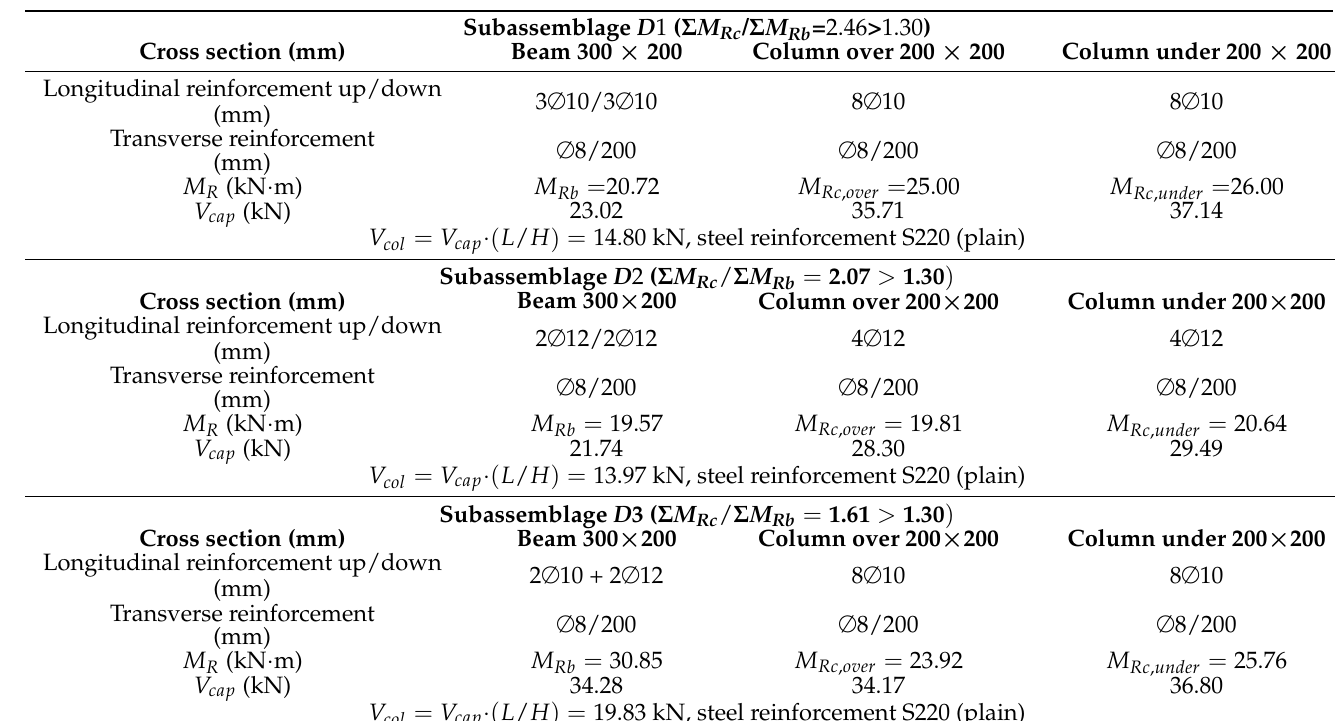
Table 3. Reinforcement, nominal flexural moment capacity, and shear capacity force of subassemblages designed in the